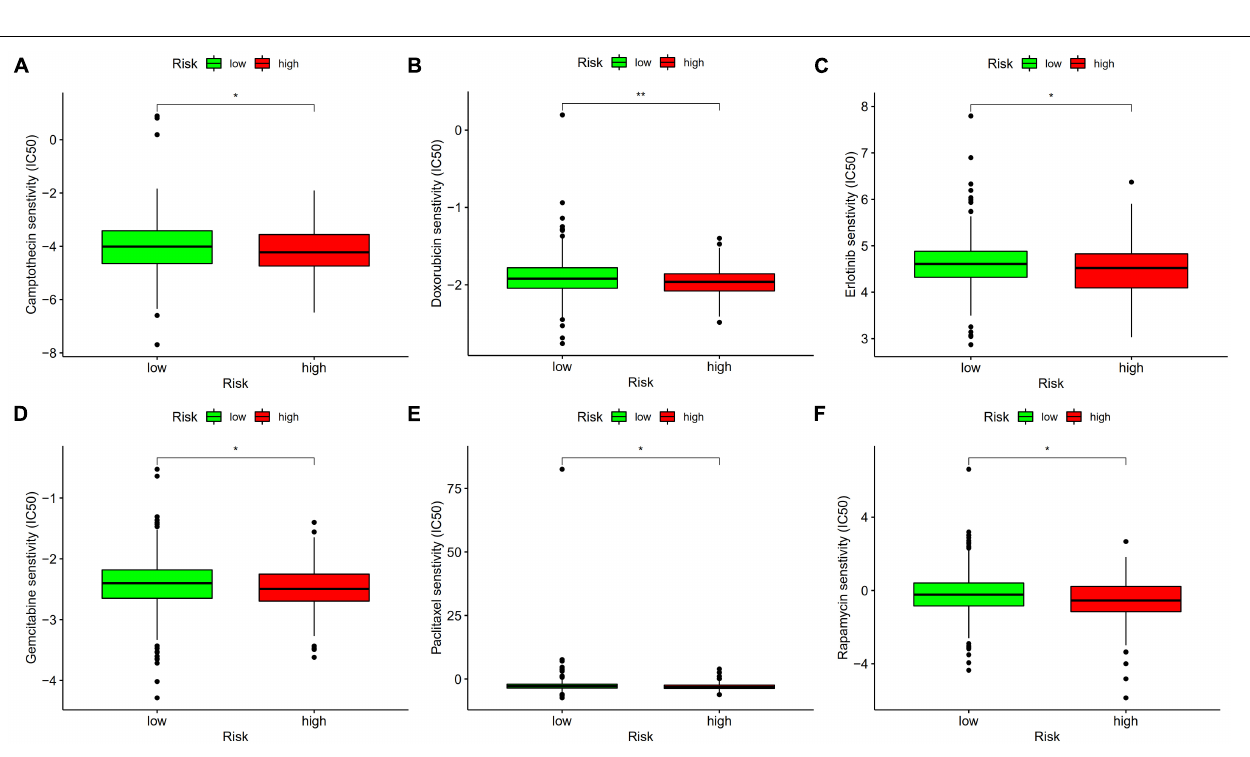
Frontiers in Cell and Developmental Biology |